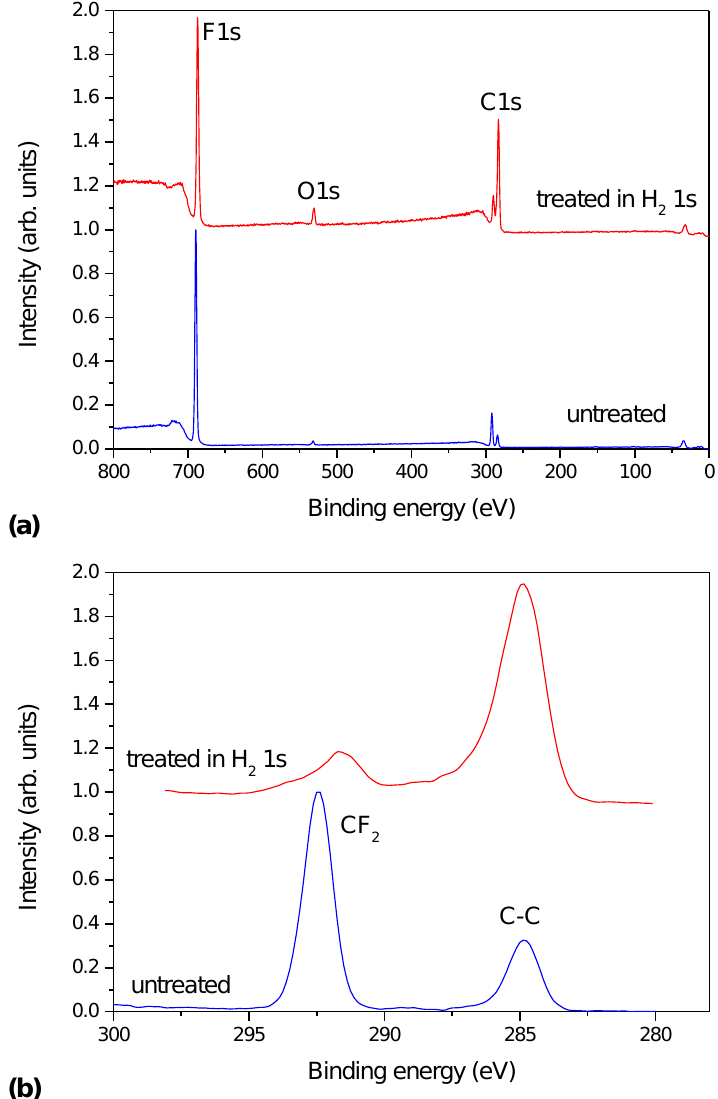
Figure 2. ( a ) The XPS survey and ( b ) high-resolution C1s spectra of an untreated sample and a sample treated with hydrogen plasma for 1 s.